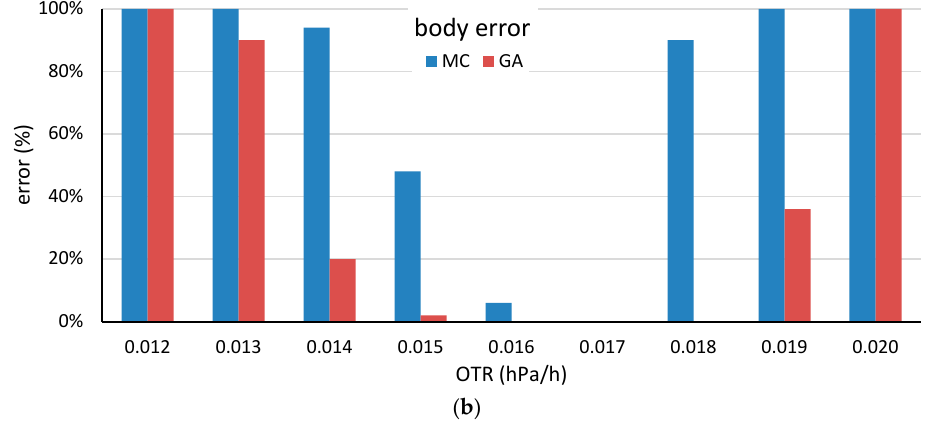
Figure 9. Error rates of the for the head stave ( a ) and the body stave ( b ) by selection method for various target OTR values obtained by using the head and body low-OTR staves. A simulation was regarded as an error if the maximum iteration time was reached without identifying a head or a body barrel with the desired OTR value.